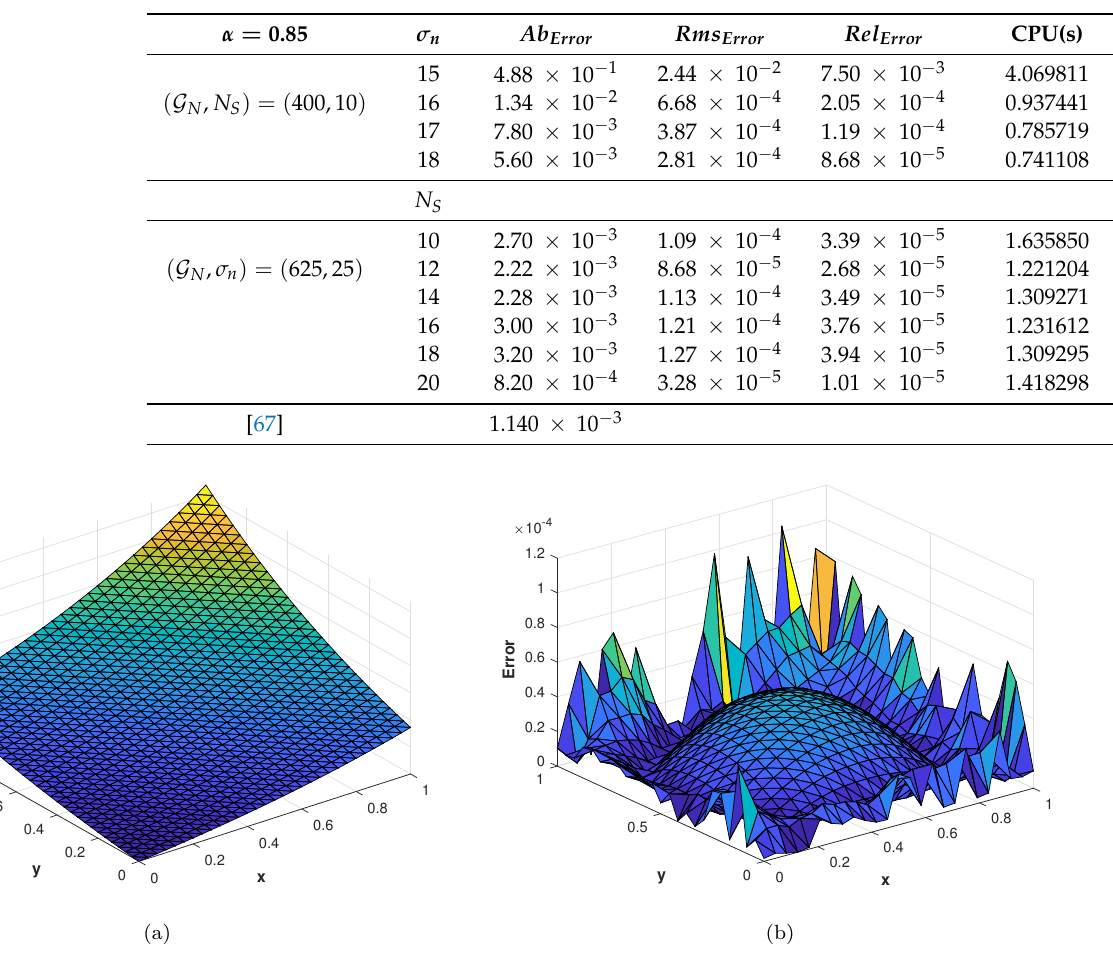
Figure 7: (a) Numerical solution of problem 2. (b) Ab Error of the proposed method computed using Figure 7. ( a ) Numerical solution of problem 2. ( b ) Ab Error of the proposed method computed using 625 , N S = 18 , σ n = 20 at T = 1 corresponding to problem 2. = 625, N S = 18, σ n = 20 at T = 1 corresponding to problem G N